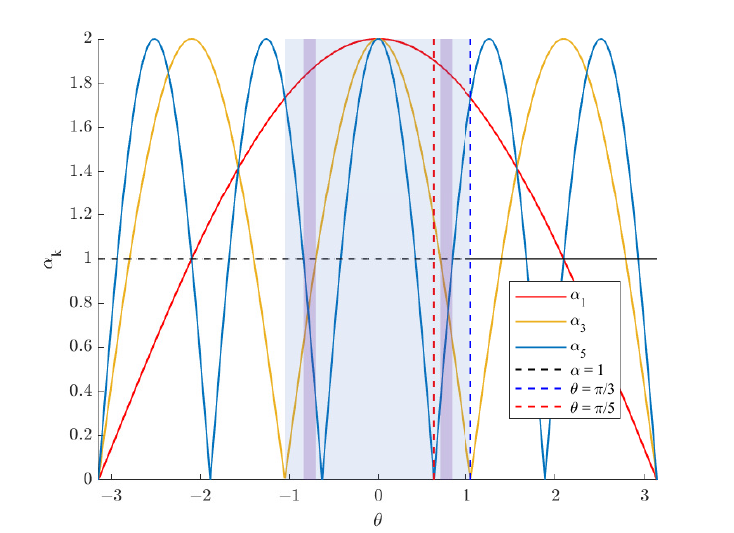
Figure 2. Harmonic suppression coefficients of different harmonic